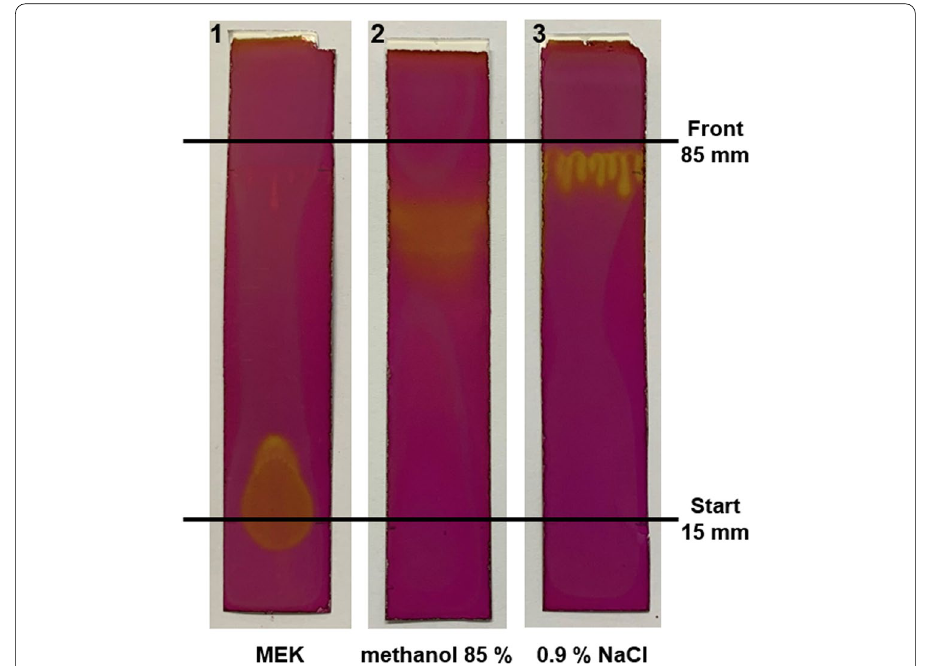
Fig. 2 Distribution of glucose on TLC SG-60 strips. Glucose (yellow spot) migrated with the solvent front in 0.9% NaCl and in 85% methanol, and remained at the origin in MEK